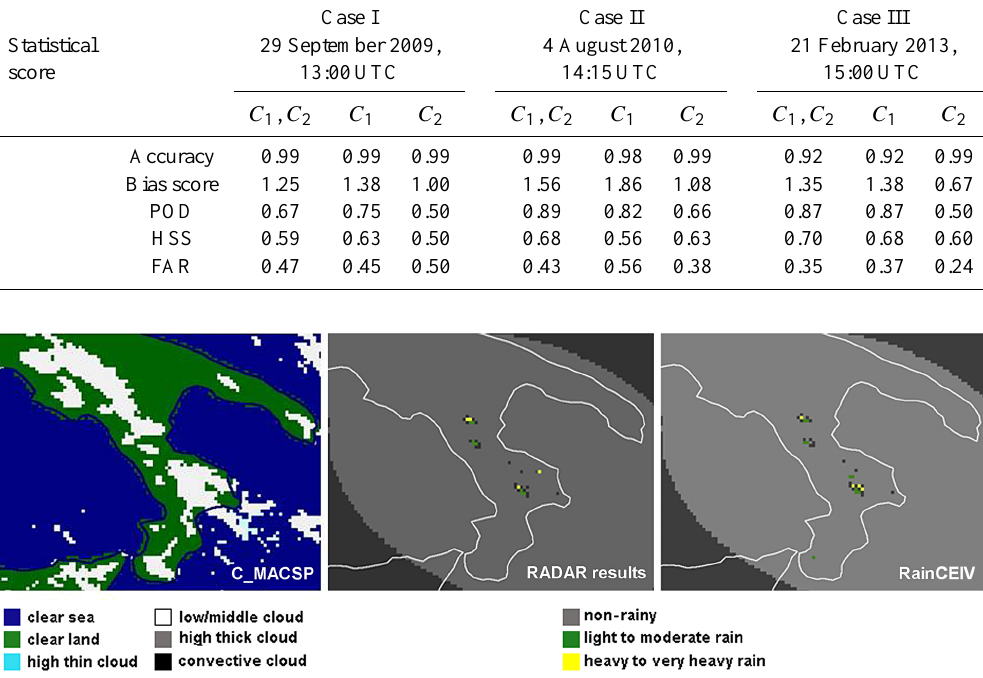
Figure 3. 29 September 2009 at 13:00UTC. From left to right: C_MACSP cloud classification results, radar-derived rain rate results, RainCEIV rain rate